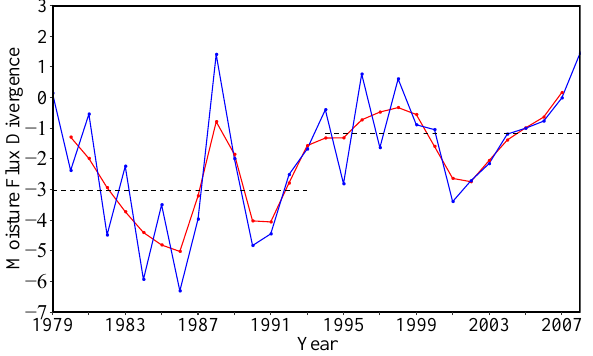
Figure 6. Time series of area-averaged vertically integrated moisture flux divergence (kg m − 2 s − 1 ) over Luzon Island (117.5–122.5 ◦ E; 10–20 ◦ N) during P45–P50. The blue (red) line is the unfiltered (1–2–1 filtered) time series. Dashed horizontal lines indicate the epochal means.